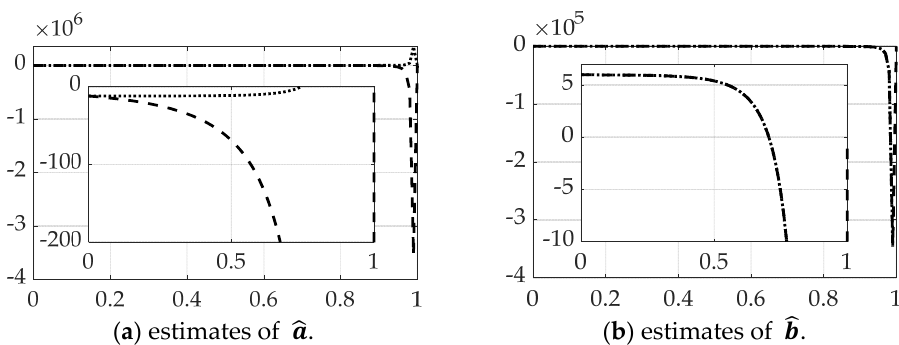
Figure 8. Comparison of real-time optimal methods with scaled time on the abscissae and respective ordinates titled in the subplot captions: dashed line is real-time optimal using backslash , dotted line is real-time optimal using backslash with singular switching. ( a ) Estimates of ˆ a , ( b ) estimates of ˆ b . The ranges of the zoomed view in the inset are indicated by the respective scales. Table 4. Comparison of real-time optimal decision methods using backslash matrix inversion.